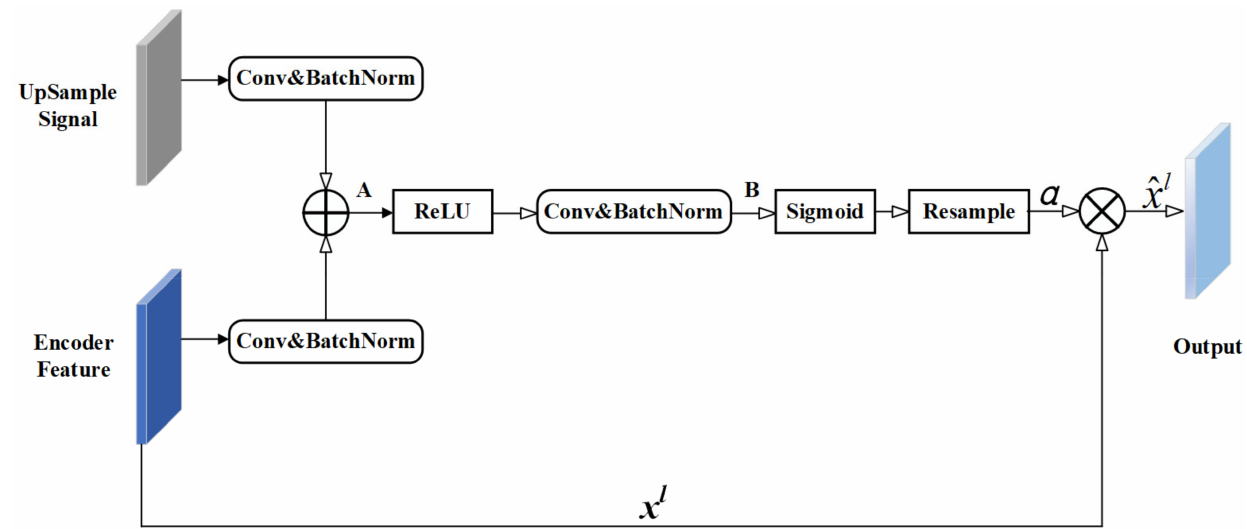
Figure 3. Architecture of Attention